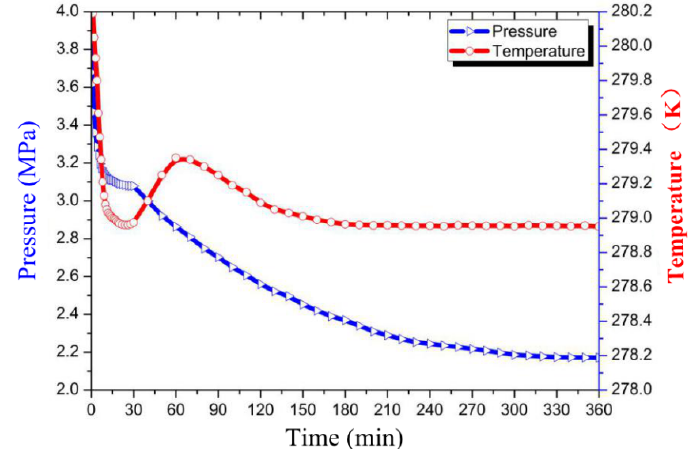
Figure 2. Temperature ‐ pressure ‐ time variation for CO 2 hydrate formation with GO .